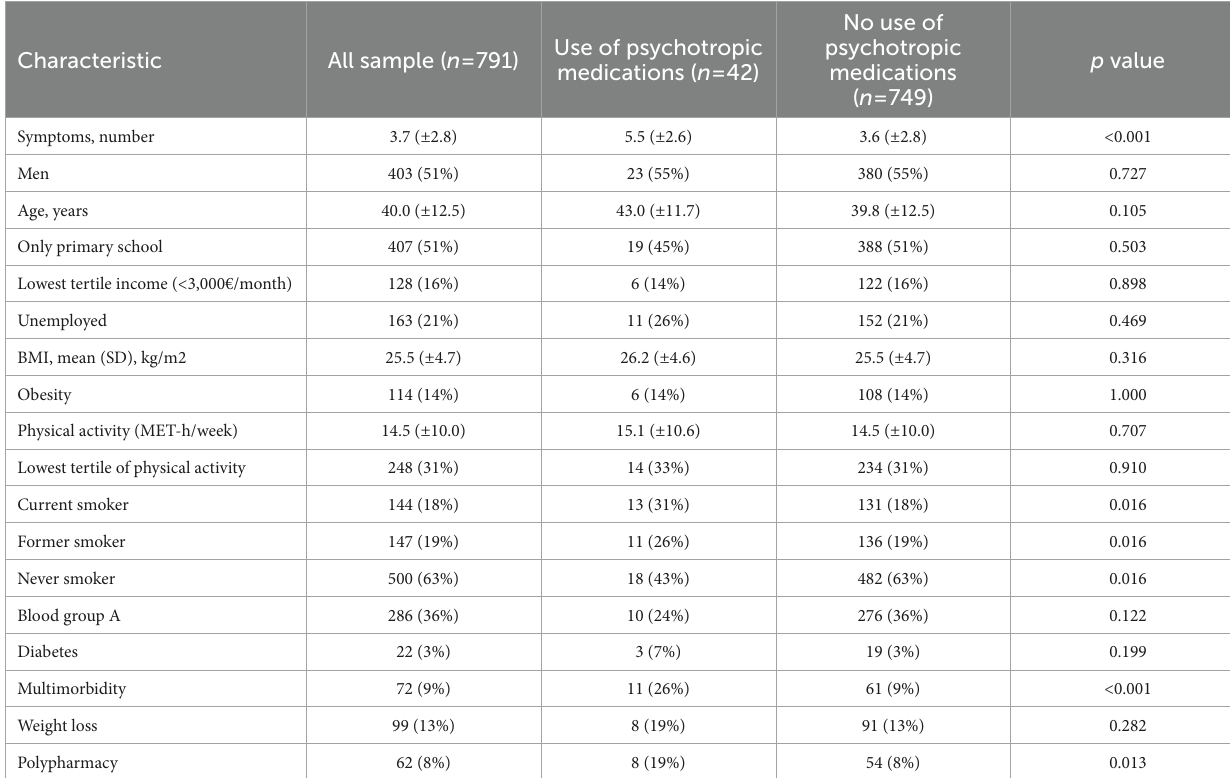
TABLE 1 Characteristics of the sample population stratified by the use of psychotropic medications.